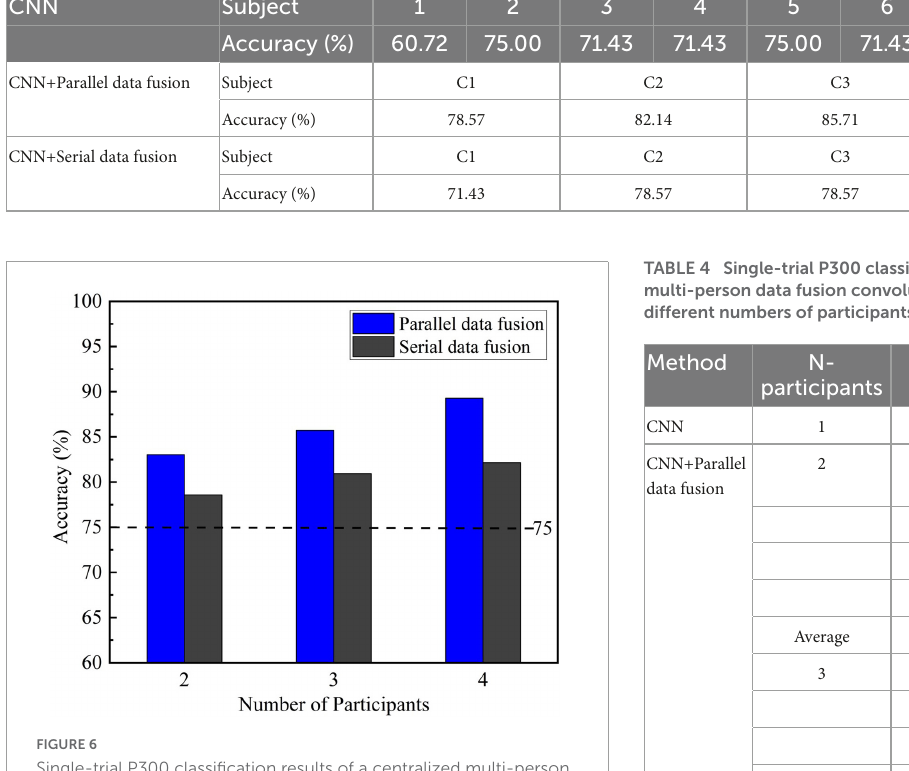
FIGURE6 Single-trial P300 classification results of a centralized multi-person data fusion convolutional neural network (CNN) for groups with different numbers of participants.